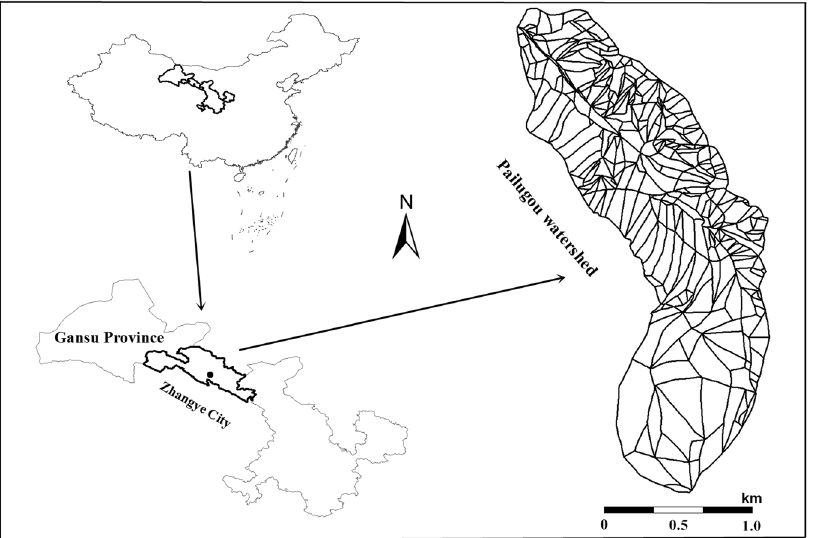
Figure 10. Location of the small watershed of Pailugou in the Qilian Mountains of northwest China, and the division of spatial units in the small watershed. This map was generated using ArcGIS 10.3